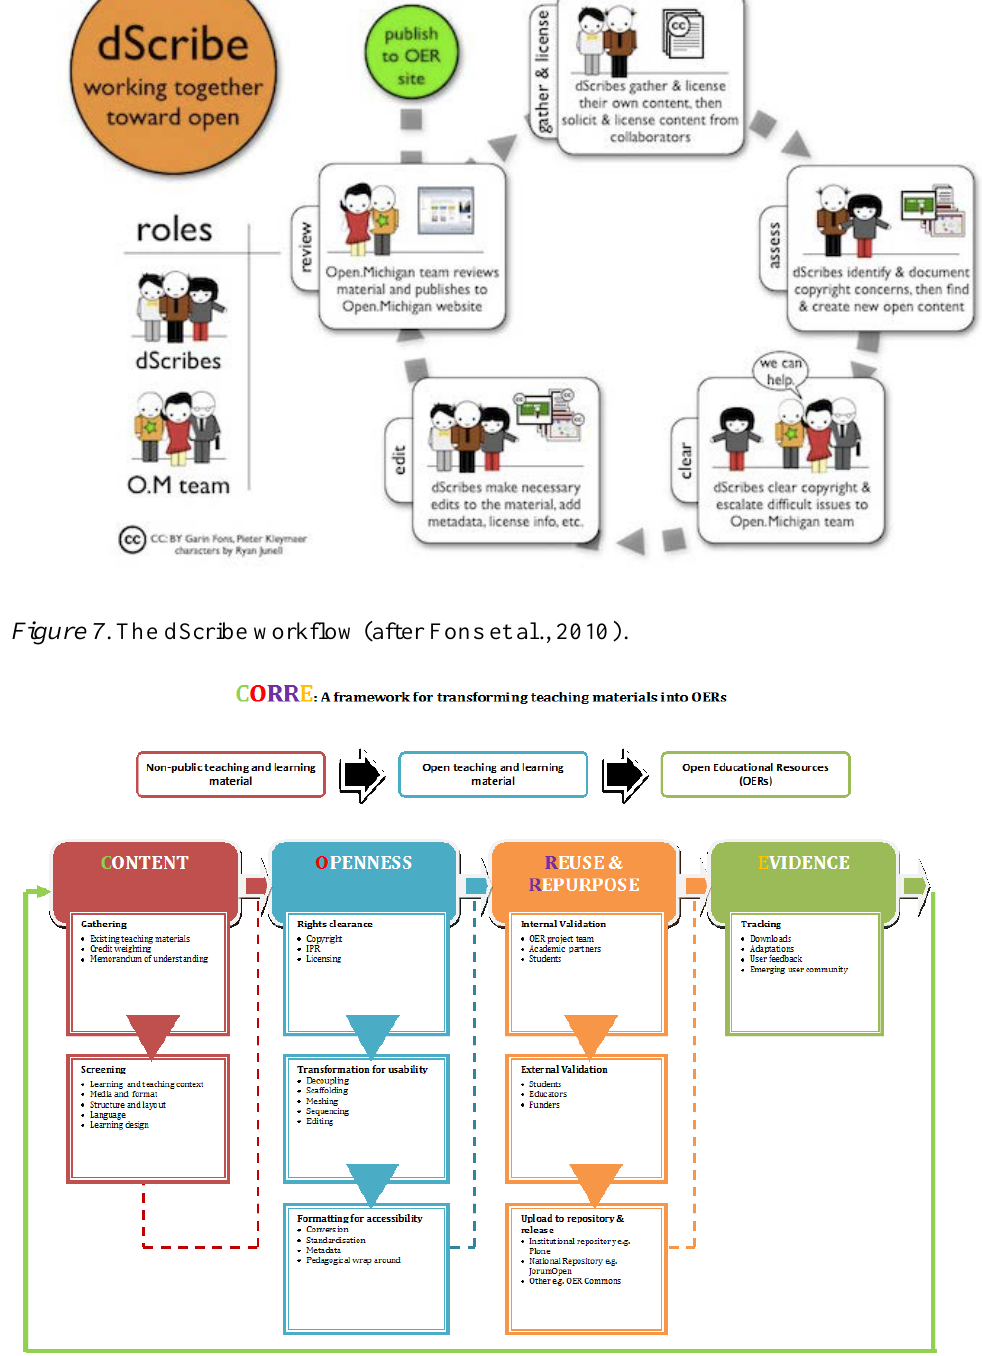
Figure 8 . The CORRE